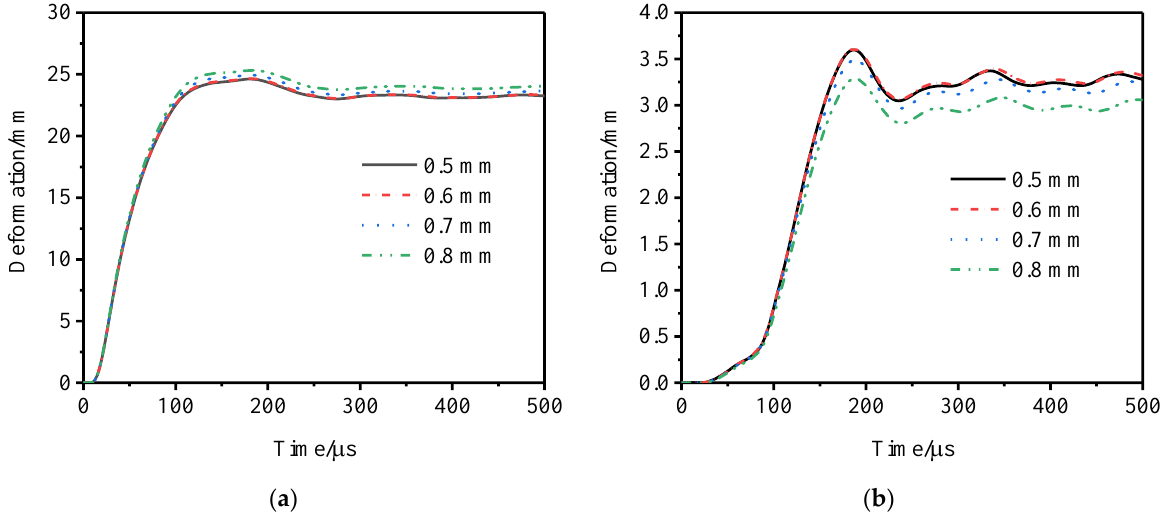
Figure 7. Deformation of inner and outer tubes with different mesh sizes. ( a ) Inner tube and ( b ) outer tube.